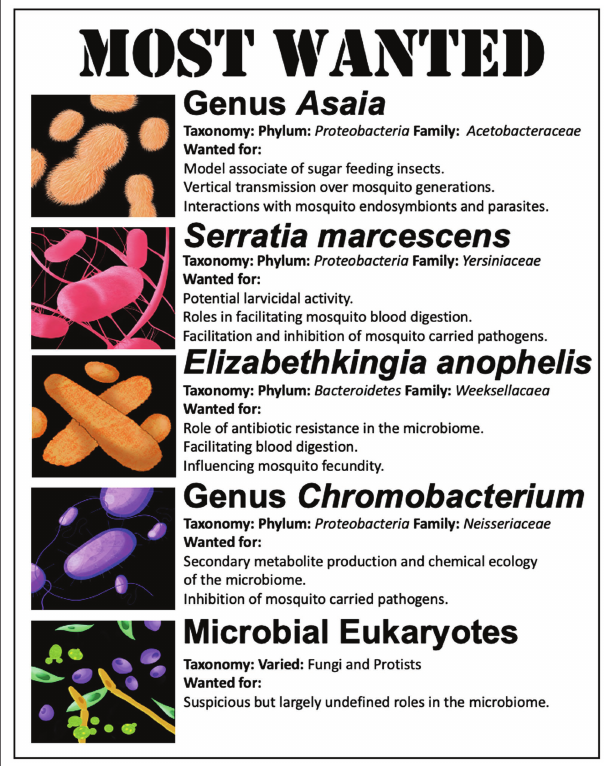
FIGURE 3 | List of organisms of significant interest for gnotobiotic studies in